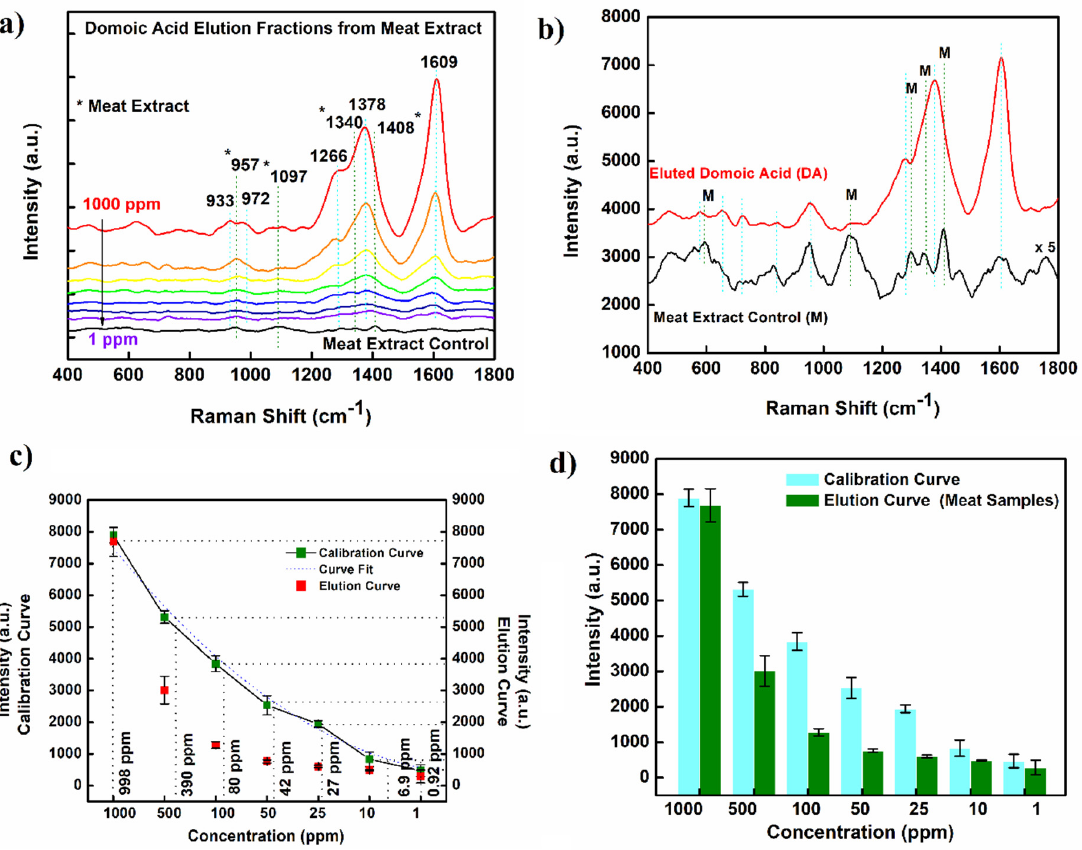
Figure 5. ( a ) Raman spectrum of different concentrations, 1000 ppm (red) to 1 ppm (violet) of DA eluted from spiked crab meal samples; ( b ) Enlarged view of the Raman spectrum acquired for eluted DA and control meat sample comparing overlapping signals; ( c ) Estimation of DA concentration from eluted samples; ( d ) Histogram of Raman signal intensity as acquired from standard data curve versus eluted samples. Notations asterisk (*) and M represent vibrational reflections from meat samples. Table 1. DA concentrations tabulated for the eluted samples from the SERS calibration curve. Tabulated Elution Effi- Spiking Concentration Concentration (ppm) Tabu- S. No ciency (ppm) lated from SERS (%)